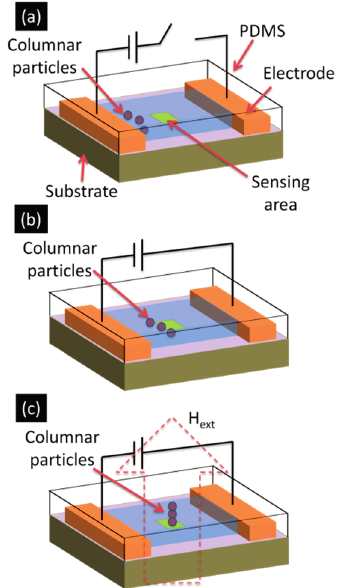
Figure 12. ( a ) An aqueous solution containing superparamagnetic micrometer size columnar beads was dropped into one of reservoirs; ( b ) An electric field was applied across the channels to manipulate the columnar beads; ( c ) The external magnetic field was applied to the microfluidic chip to detect the 130-nm-diameter target beads immobilized on the surface of channels. Adapted from [11].